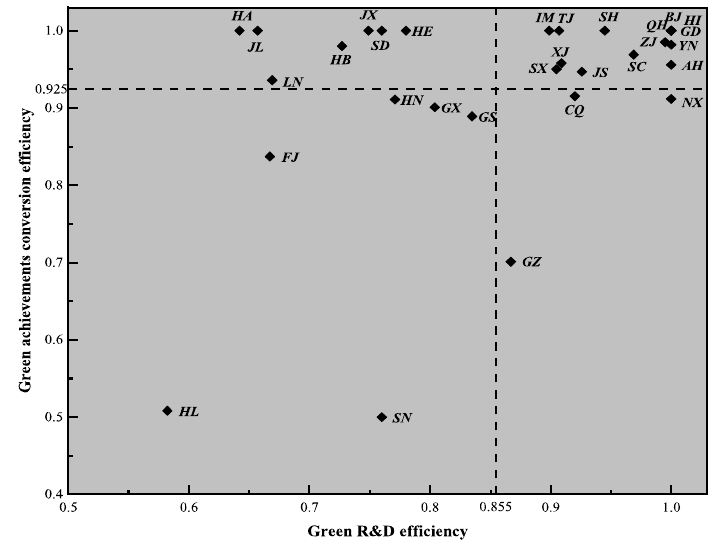
Figure 10. The regional classification of industrial enterprises’ green technology innovation under different combination modes.